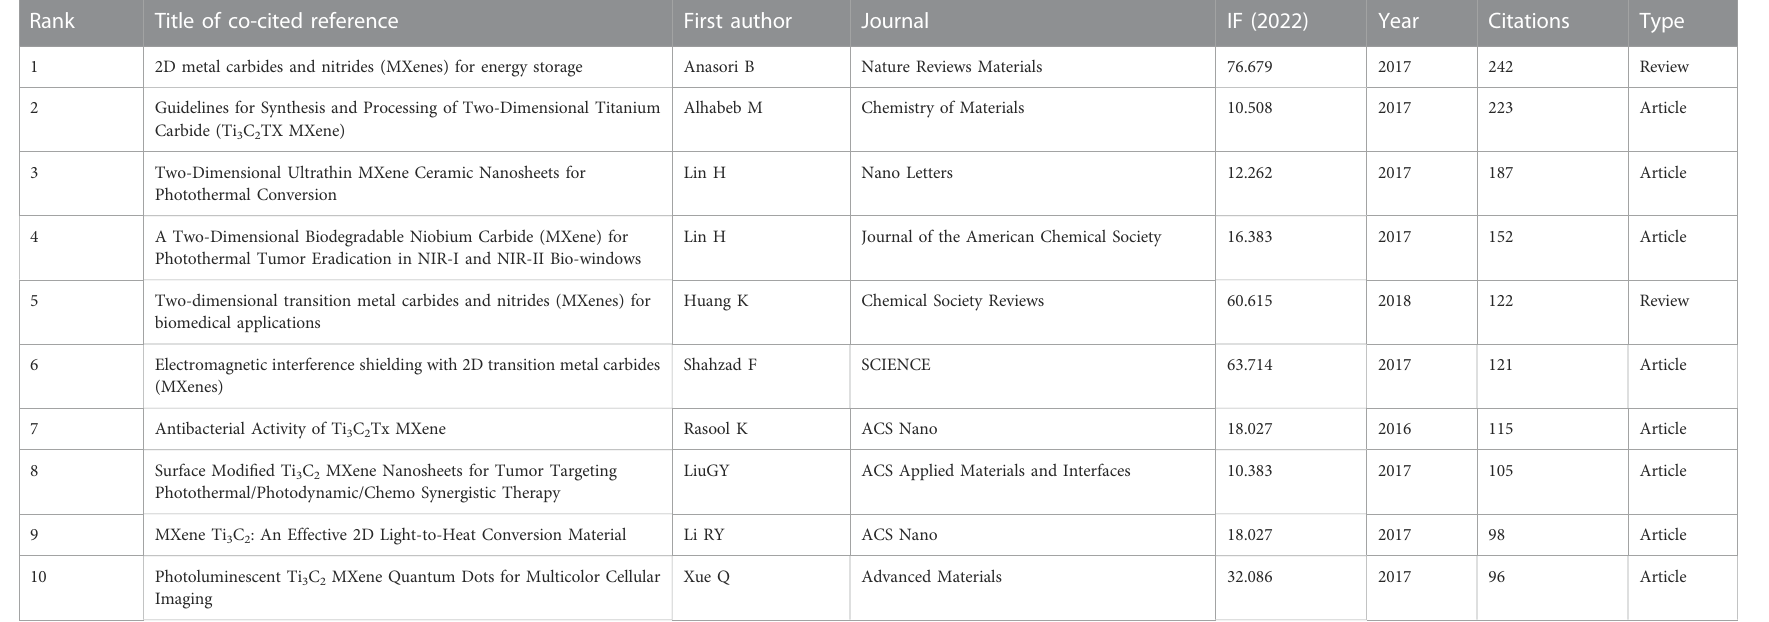
TABLE 2 Top 10 co-cited references and corresponding journals, IF and